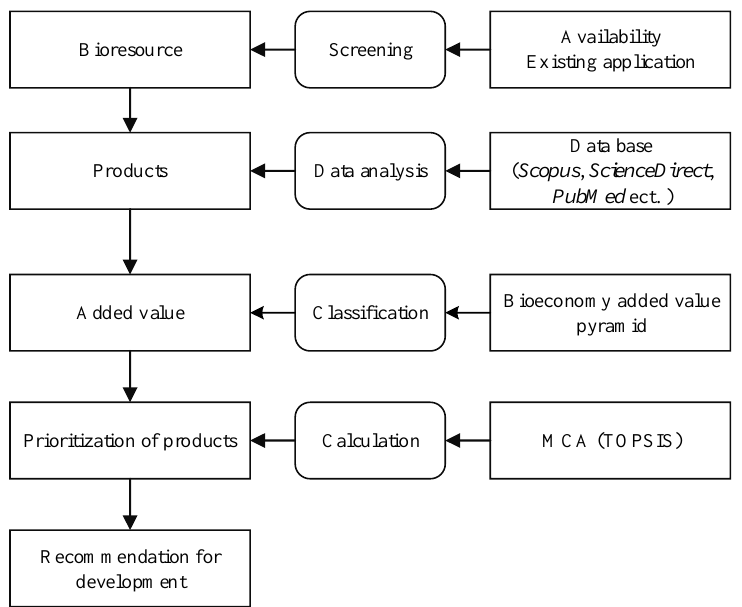
Fig. 1. The algorithm of the